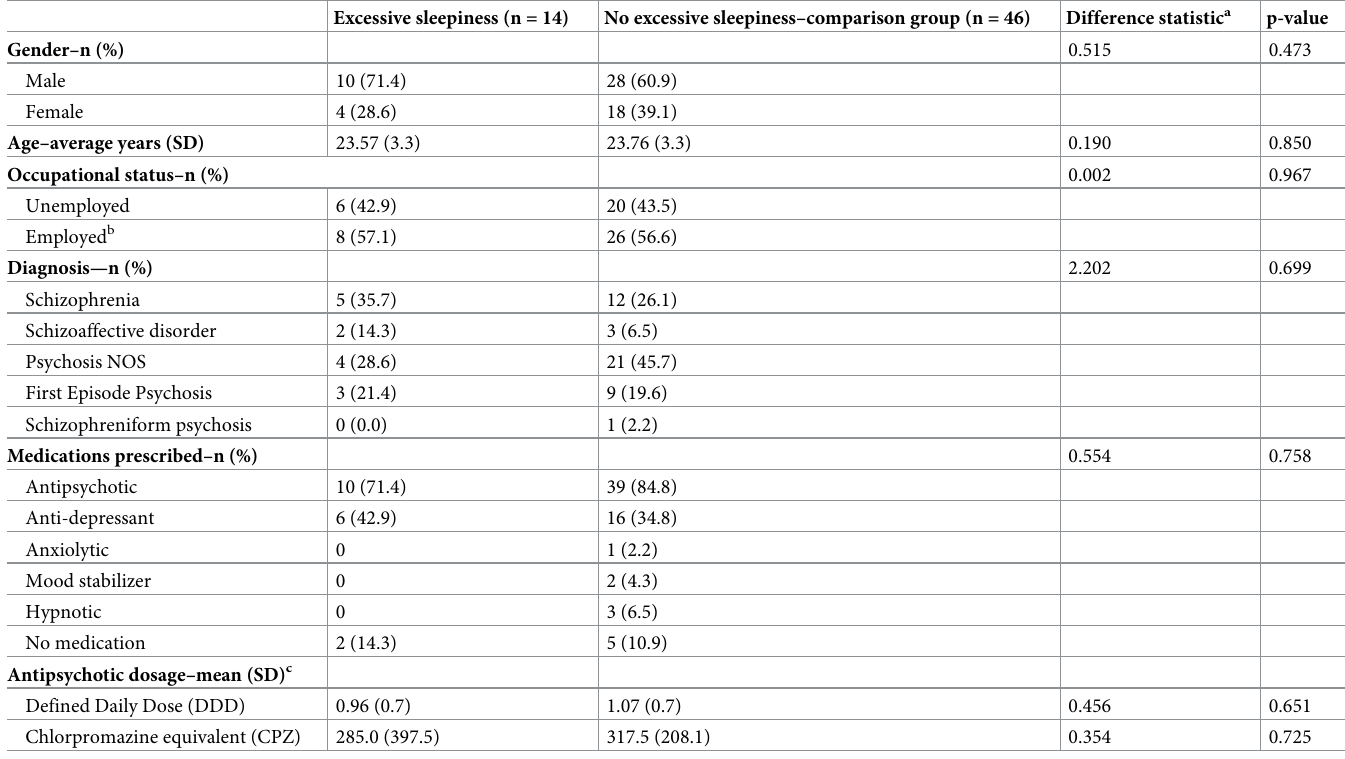
Table 1. Demographic and clinical differences between the excessive sleepiness and comparison